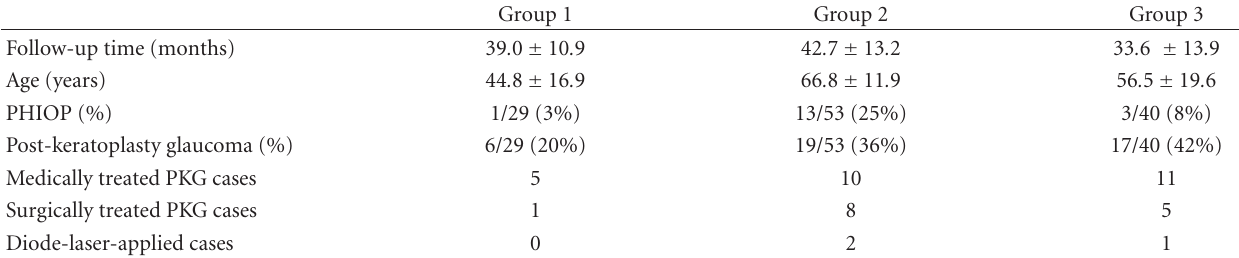
Table 3: The number of eyes (%) with previous high intraocular pressure (PHIOP) and post-keratoplasty glaucoma (PKG) and the PKG cases requiring medical or surgical treatment according to the indications of penetrating keratoplasty.